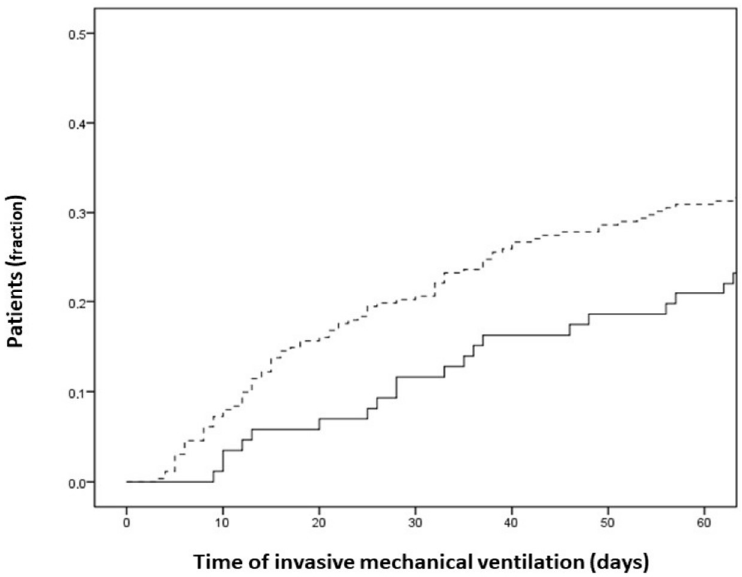
Figure 1. Cumulative probability of developing ventilator-associated pneumonia after initiation of invasive mechanical ventilation in patients receiving (solid line) and non-receiving (dotted line) selective digestive